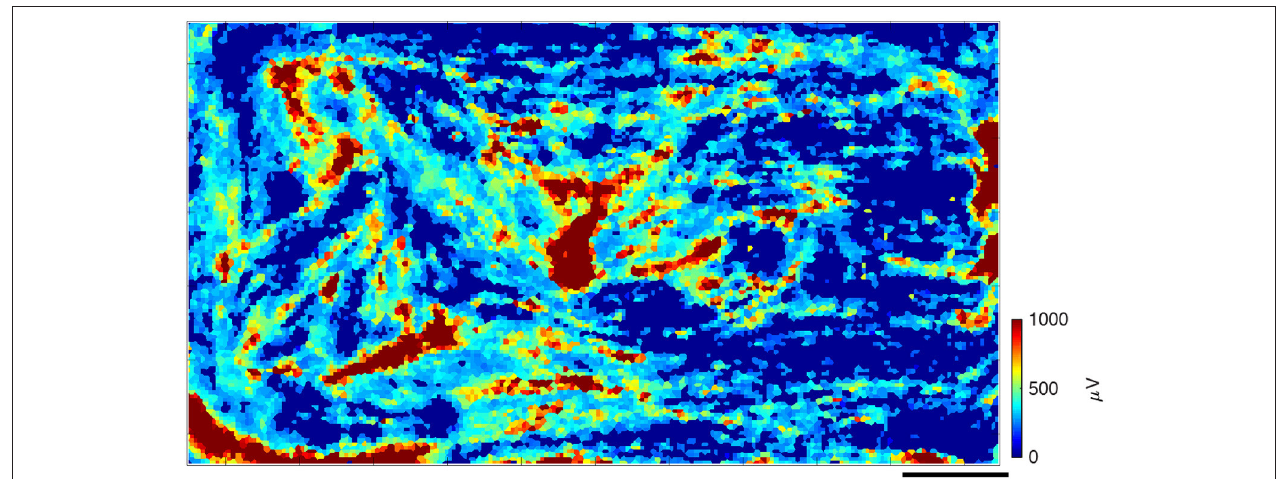
FIGURE 1 | Spontaneous spiking profile, shown as a heat map of spike amplitudes after about 1 month in culture. Every square represents an electrode, whose color corresponds to the spike amplitudes that were recorded, averaged over the data-taking period. Large red “islands” of high-amplitude spikes are surrounded by lower-amplitude spiking filaments that connect them. In dark blue areas, no spikes were recorded. Scale bar is